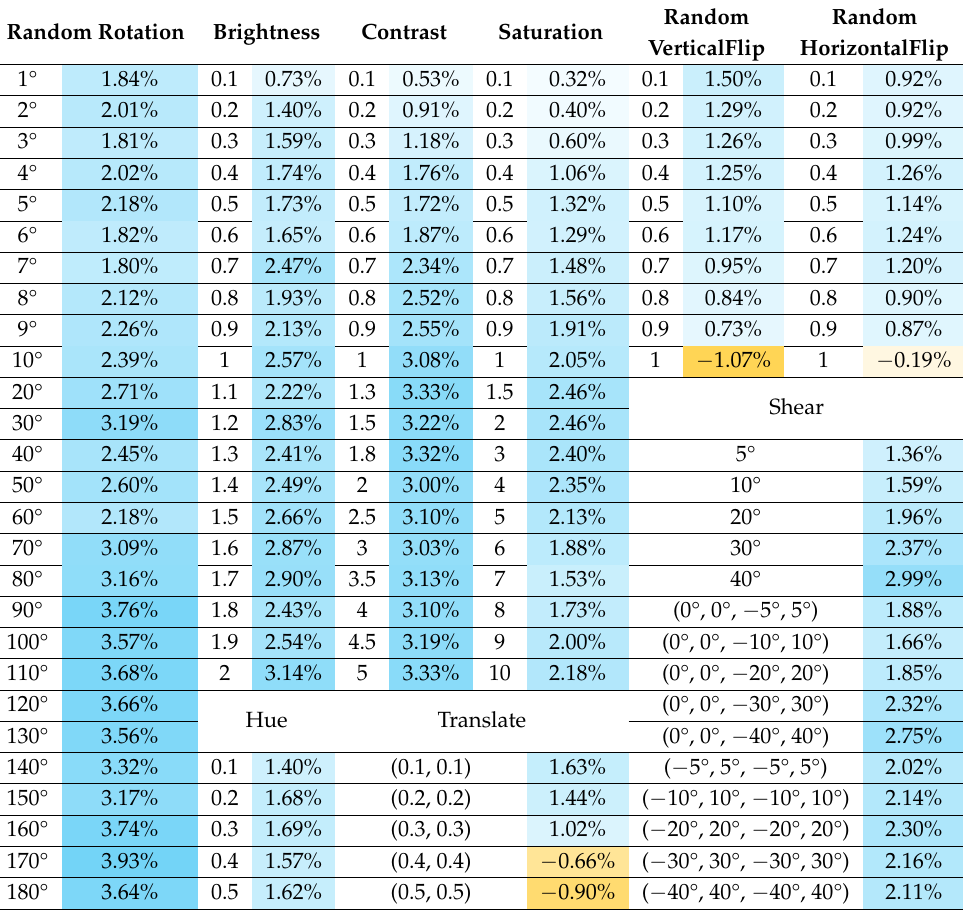
Table 7. Performance of DA methods on Γ train 100 . The effect of different DA methods and different CCZ parameters on Γ train 100 classification mAA improvement is shown. The displayed percentage values CCZ describe the increase/decrease of mAA in percent. The value is color-coded from blue (increase in accuracy) over white (no effect) to orange (decrease in accuracy).